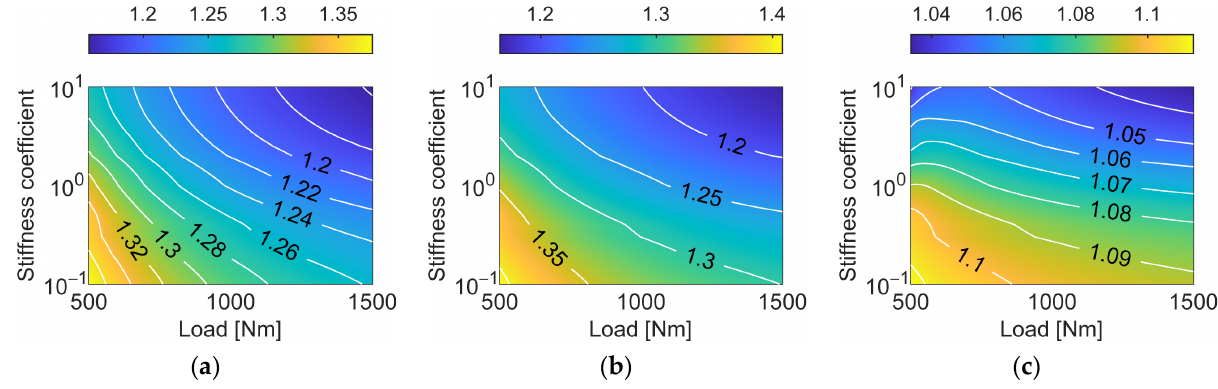
Figure 18. In fl uence of support sti ff ness of tail gear on load-sharing coe ffi cient: ( a ) Input Gear 1; ( b ) Input Gear 2; ( c ) idler gear.